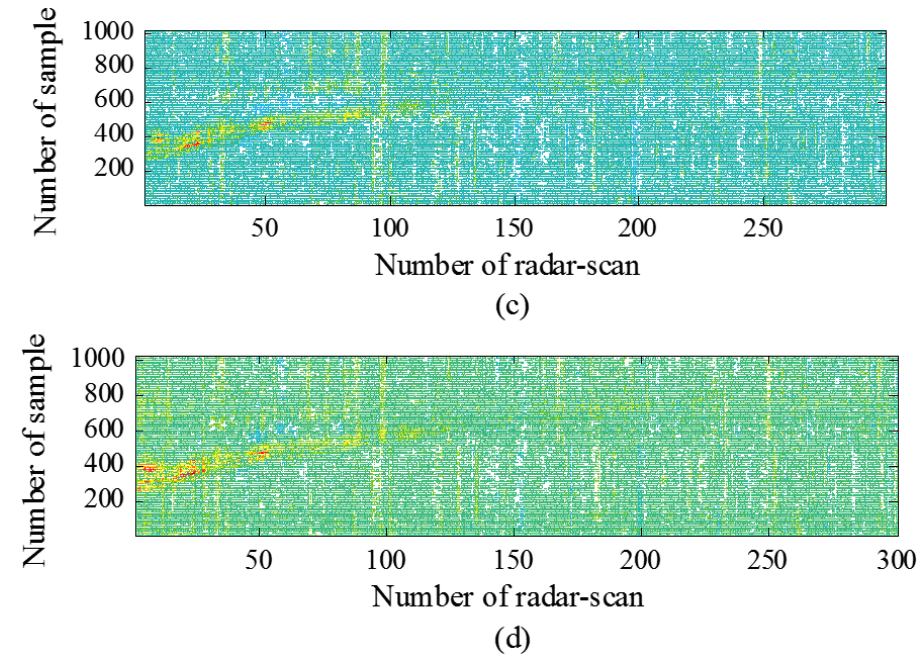
Figure 7. Radargrams: ( a ) before clutter reduction; ( b ) after application of EA clutter reduction; ( c ) after application of SVD clutter reduction; and ( d ) after application of KF-based clutter reduction.